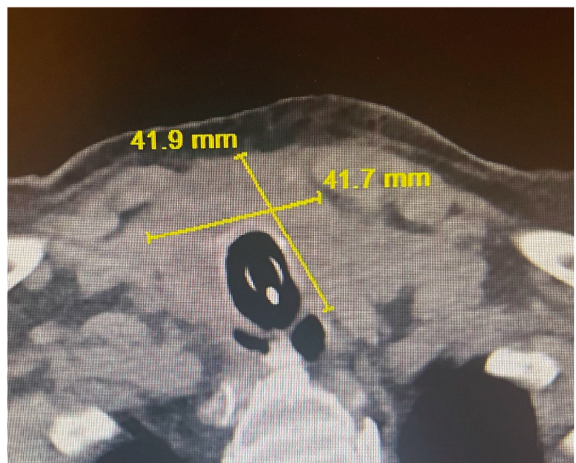
Figure 2: Following chemotherapy, the patient’s CTneck scan with contrast showed a significant decrease in the thyroid size measured approximately 4.2 × 4.2cm, with marked improvement in tracheal